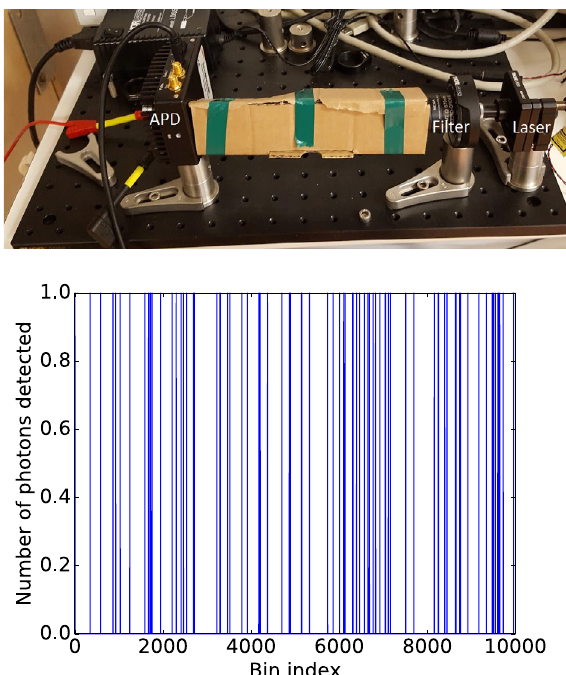
Fig. 2. Upper panel : Picture of the setup. The laser source is a 50 mW laser diode attenuated by two neutral density fi lters. Photons are detected using an avalanche photo-diode (APD) operated in single-photon counting mode. Lower panel : Example of detection signal. Two separated bins are separated by a 19 m s